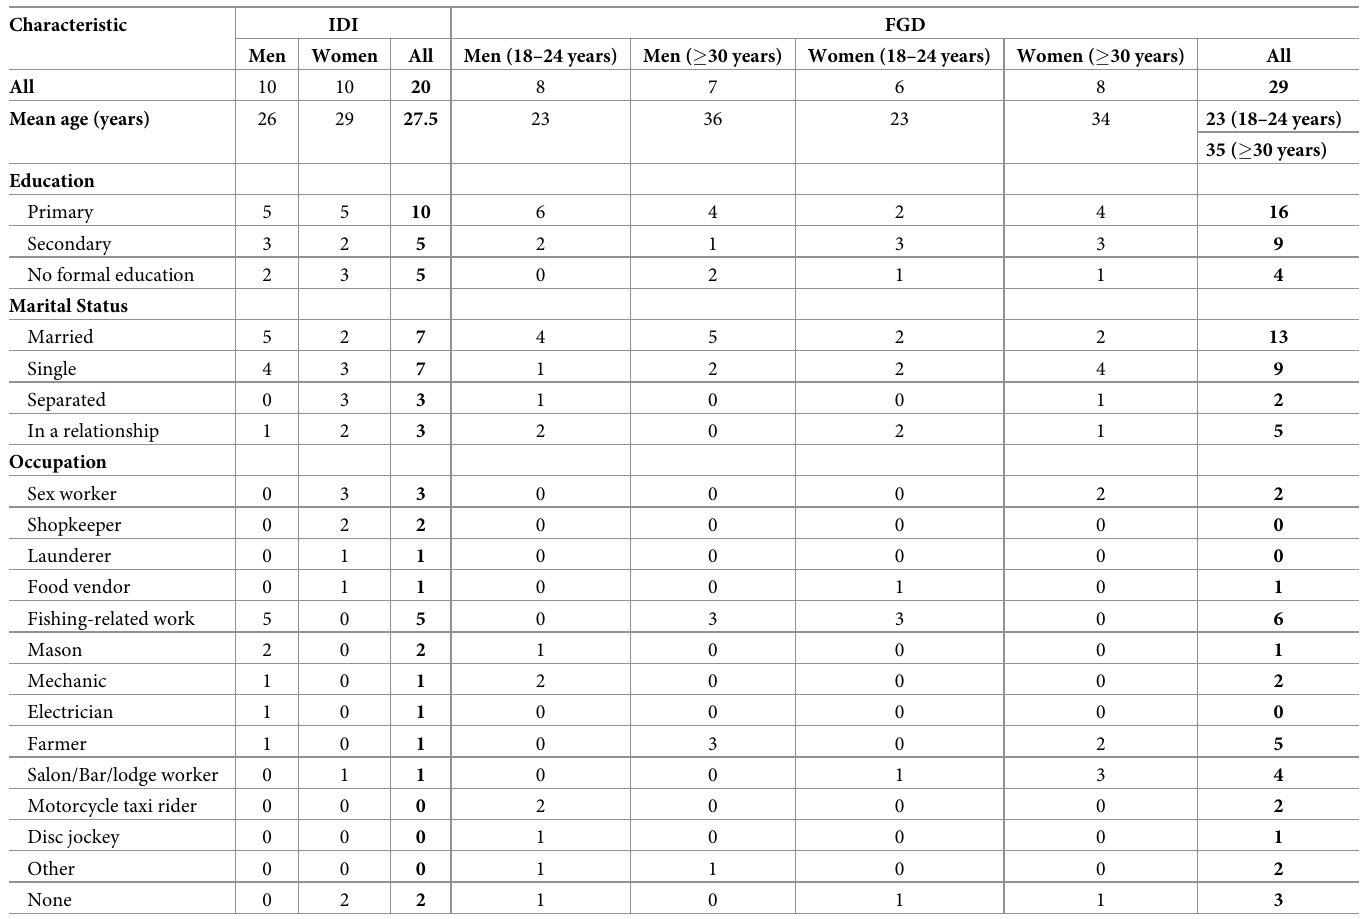
Table 1. Characteristics of study